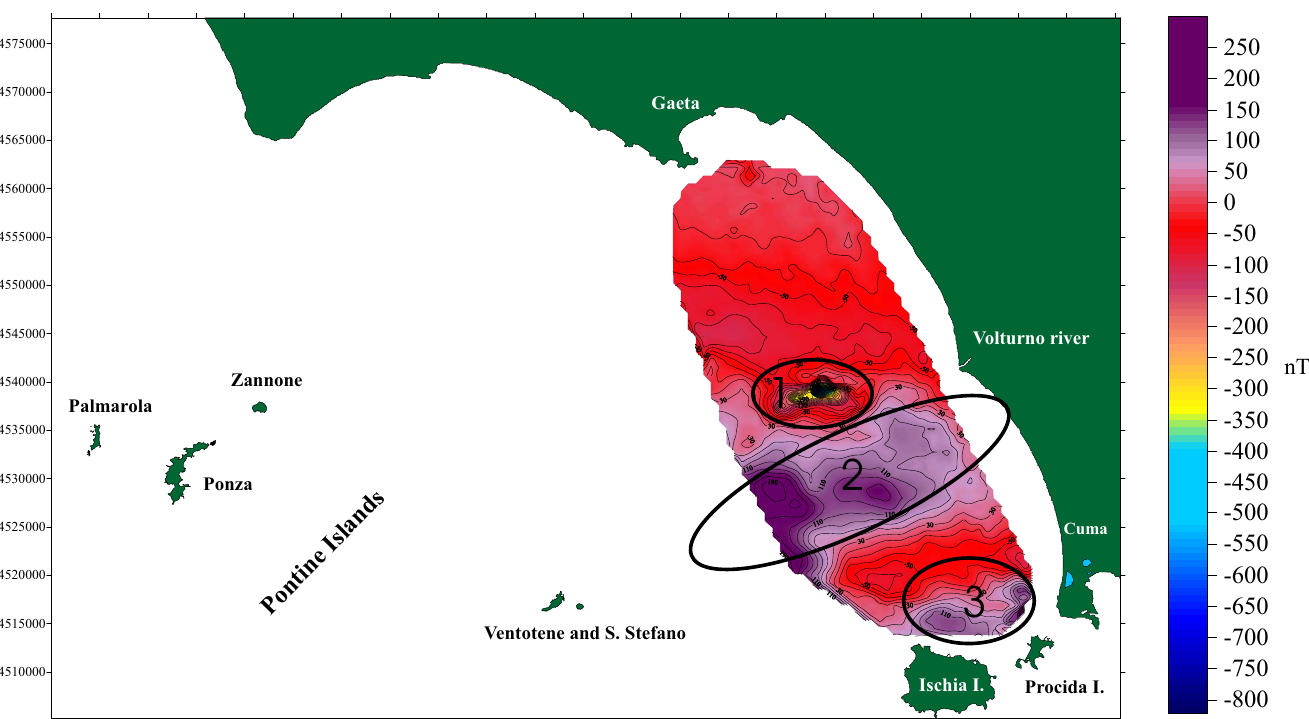
Figure 10. Anomaly map of the total magnetic field offshore between Gaeta Gulf and Ischia Island (reported from Aiello et al. [2005a]; see also Ruggieri